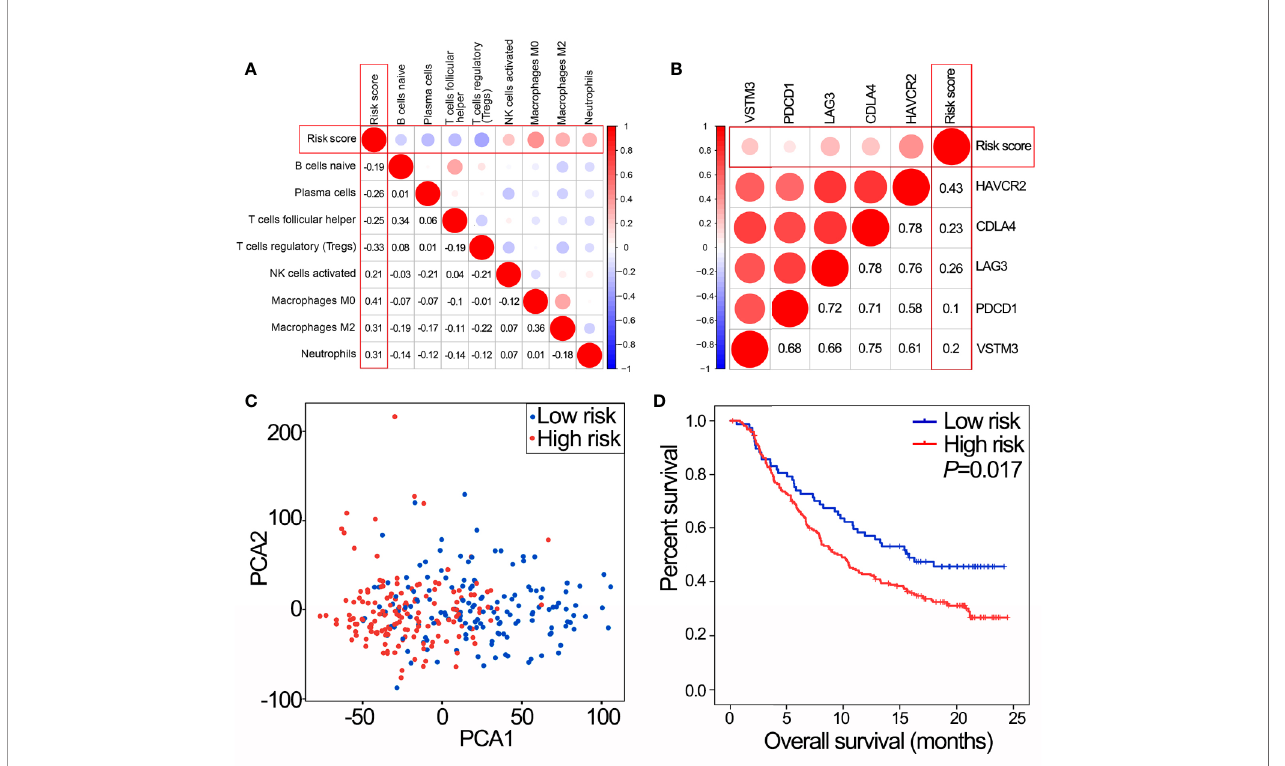
FIGURE 5 | IPS predicts immunotherapy bene fi ts. (A) The correlation between risk score and proportions of tumor-in fi ltrating immune cells in GSE32894 data set. The value represents the value of the correlation coef fi cient. (B) The correlation between risk score and expression of immune checkpoints in GSE32894 data set. The value represents the value of the correlation coef fi cient. (C) PCA of the total RNA expression pro fi le in GSE32894 data set. (D) Kaplan-Meier overall survival curves for patients assigned to high and low risk groups in the IMvigor210 trial. IPS, immune prognostic signature; NMIBC, non-muscle-invasive bladder cancer; MIBC, muscle-invasive bladder cancer; PCA, principal components analysis.